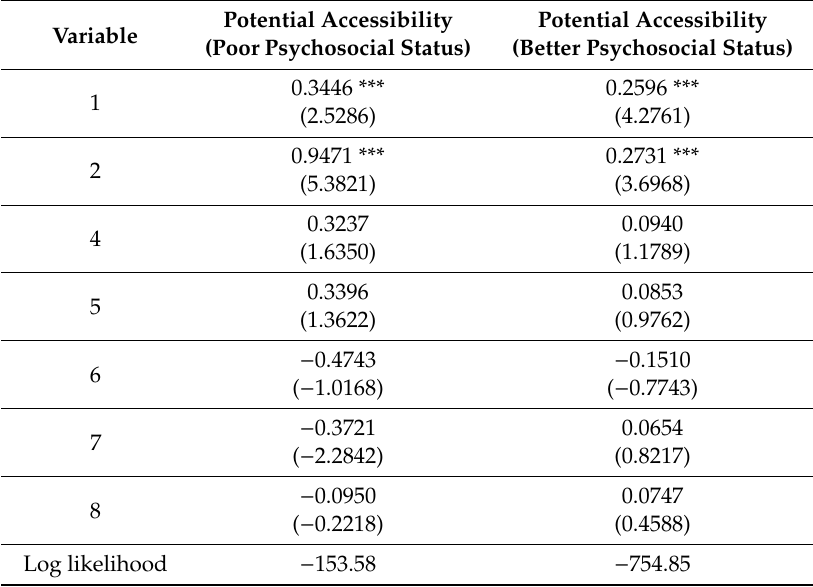
Table 3. The impact of psychosocial status on potential